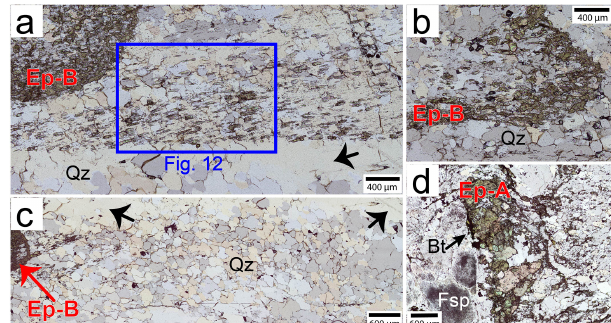
Figure 4. Transmitted-light scans of the microstructural domains described in Sect. 5.1. Microstructures in (a–c) are used for mi- crostructural analysis (Fig. 7, Sect. 5.1.2). The blue rectangle in (a) indicates the location of the cathodoluminescence image of Fig. 12. Bt: biotite; Ep-A: Epidote-A; Ep-B: Epidote-B; Fsp: feldspar; Qz: quartz. Plane-polarized light. The anomalous birefringence is due to the thickness of the section (ca.